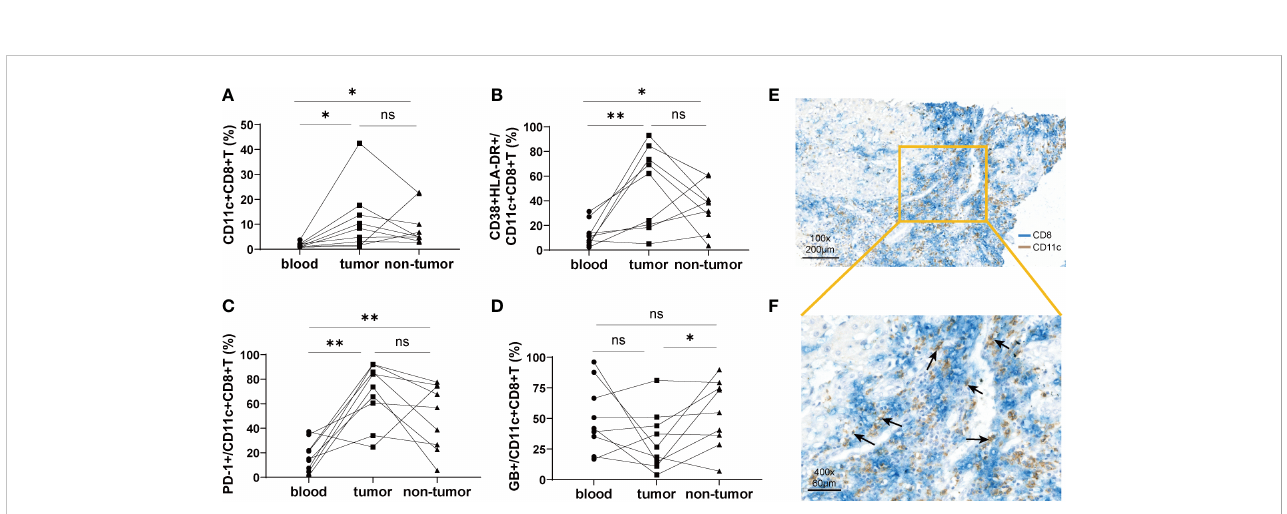
FIGURE 3 The distribution of CD11c + CD8 + T cells in tumor tissue and paired non-tumor tissue. (A) The frequency of CD11c + CD8 + T cells in the peripheral blood, tumor, and non-tumor tissues. (B – D) Paired analysis of the CD38 & HLA-DR, PD-1, and GB expression on the CD11c + CD8 + T cells in the peripheral blood, tumor, and non-tumor tissues. (E, F) Representative results of immunohistochemical double staining of CD11c (brown) and CD8 (blue) from a patient with HCC. The orange square indicates the demarcation area between cancer and para-cancerous tissue. The black arrows point to the CD11c + CD8 + T cells. The data were from 9 HCC patients who have matched peripheral blood, tumor and non-tumor tissues. P values were generated using the Wilcoxon paired test between the two groups. * P < 0.05; ** P < 0.01; ns, not signi fi